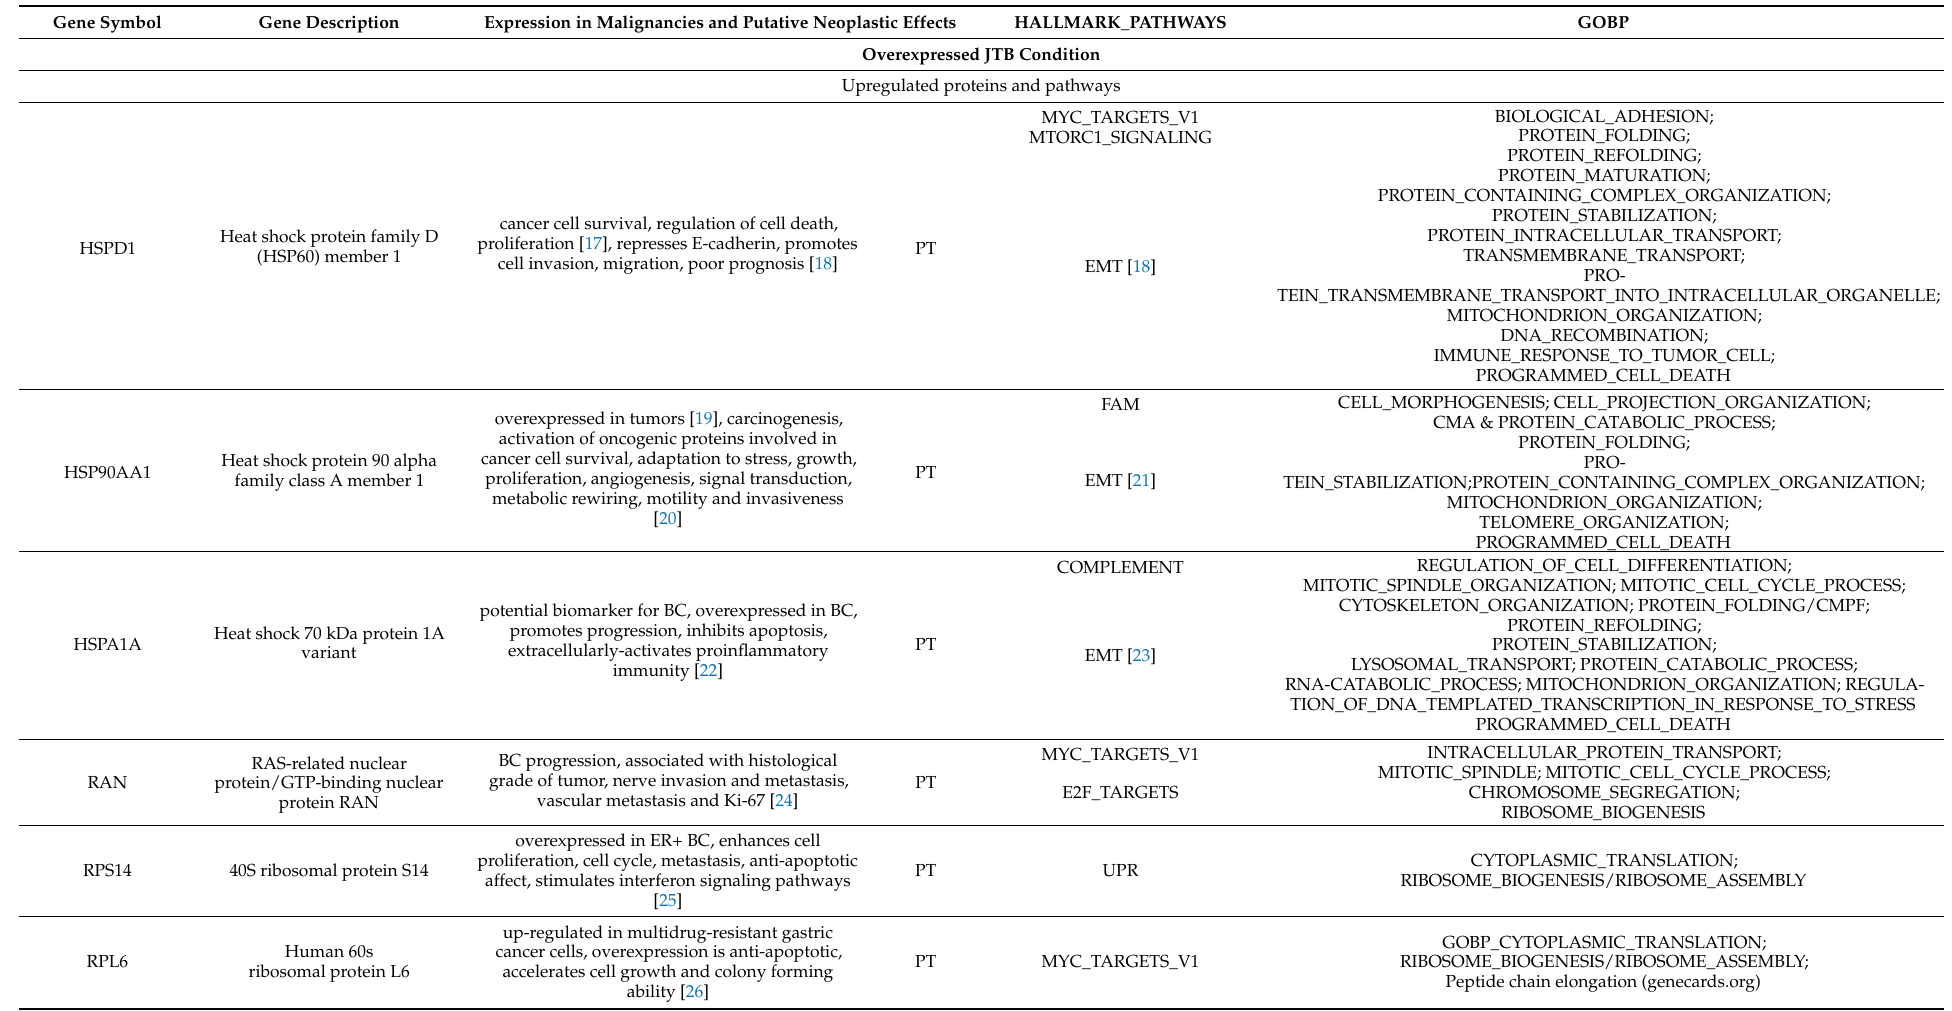
Table 3. Deregulated proteins, tumorigenic roles, and biological processes expressed in response to JTB